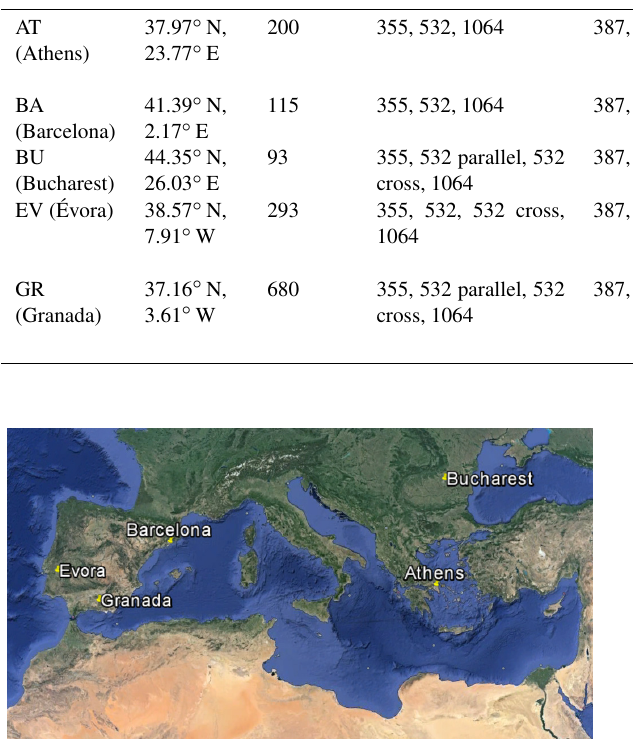
Figure 1. Stations where the LIRIC algorithm was applied dur- ing the ChArMEx/EMEP 2012 intensive measurement period on 9–11 July. Source: Google